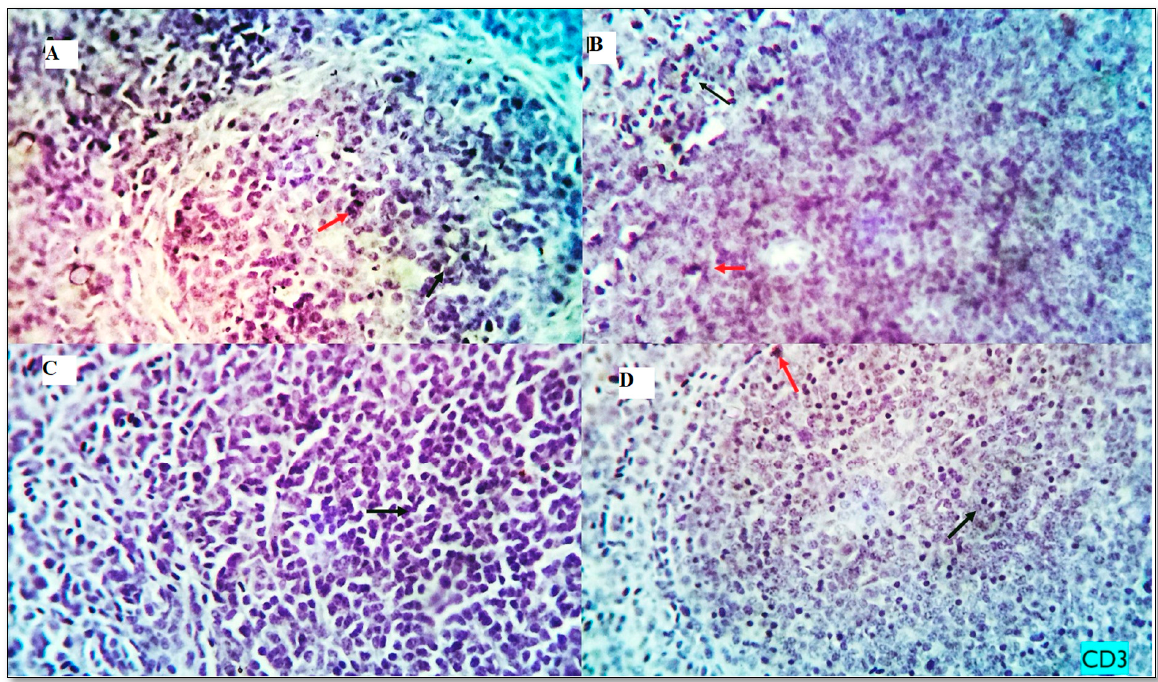
Figure 4. The immunostained positive CD3 cells (red arrows) and negative cells (black arrows) in the spleen of different experimental groups. ( A ): MUR0, ( B ): MUR200, ( C ) MUR400 and ( D ): MUR600.